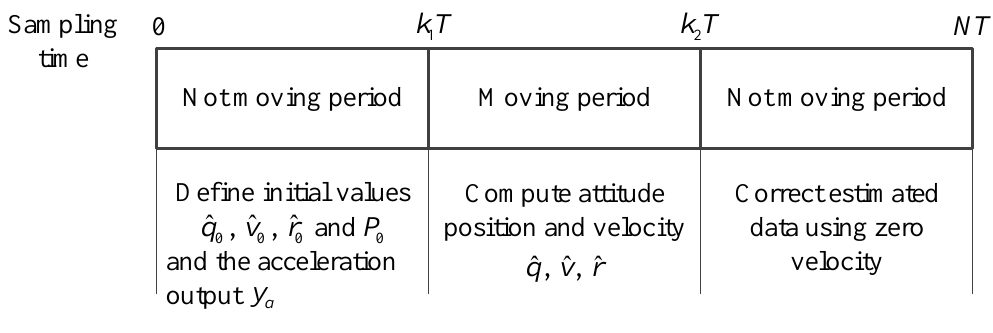
Figure 1. Standard inertial navigation algorithm with zero velocity